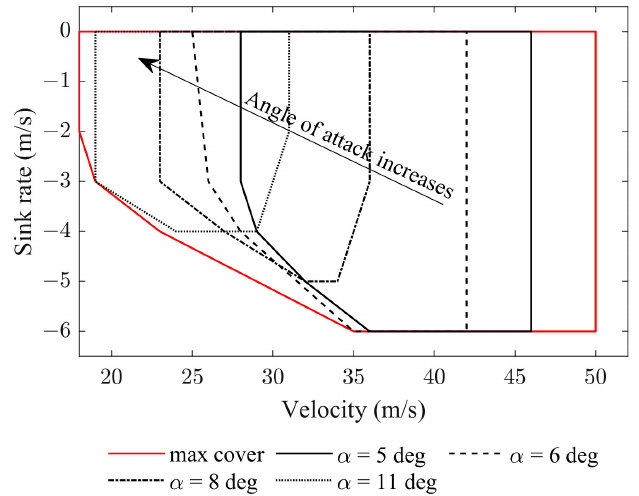
Figure 9. Reachable area for different angles of attack (angle of attack, α = 3~12 deg).